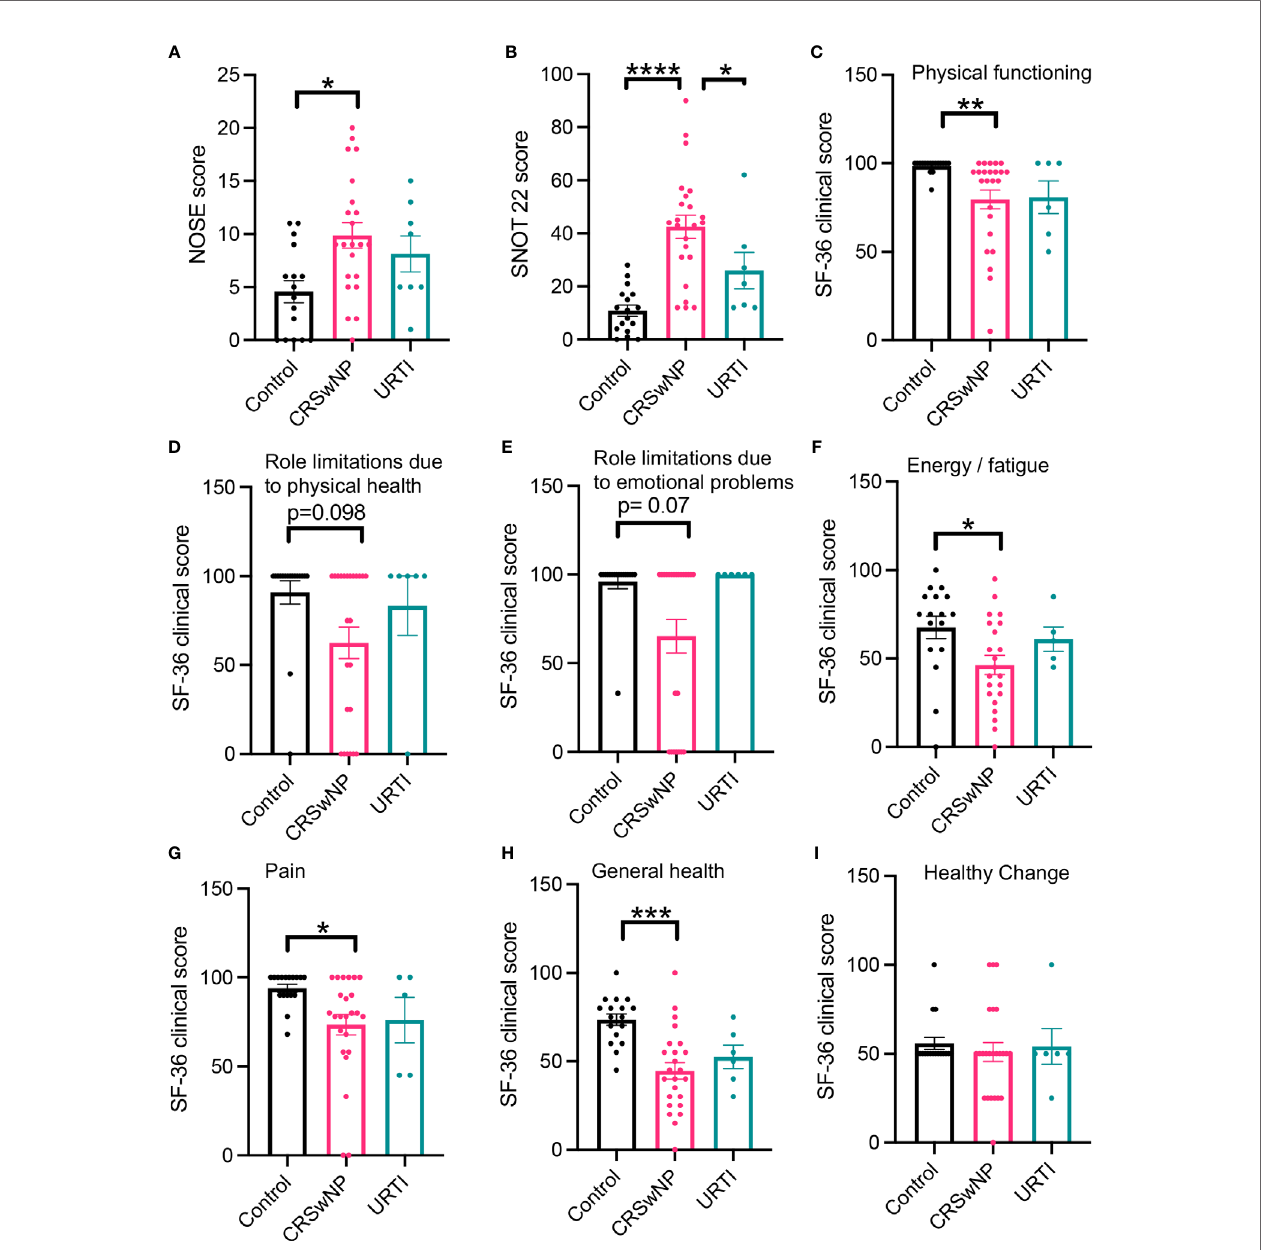
FIGURE 1 | Participants with CRSwNP have increased nasal cavity clinical scores and report poor quality of life. Compared with healthy participants and those who have recovered from an URTI, CRSwNP report worse nasal cavity complaints (A, B) . CRSwNP also report comparatively lower QoL scores (C – I) . Kruskal-Wallis test used to identify differences between the mean ranks of at least one pair of the groups. Dunn ’ s pairwise tests was carried out to identify differences between group pairs. *p < 0.05, **p = < 0.01, ***P < 0.001, ****p <